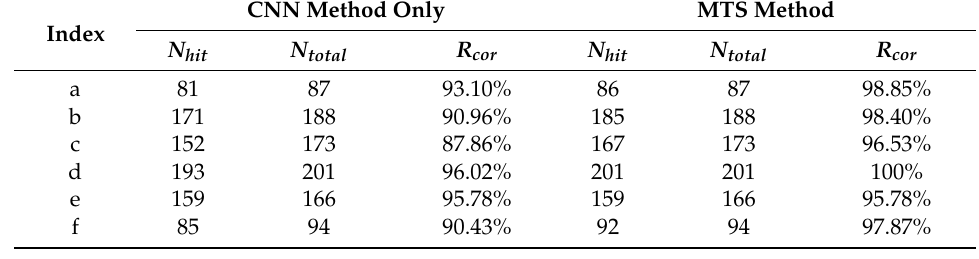
Table 4. Recognition results for the stationary state.